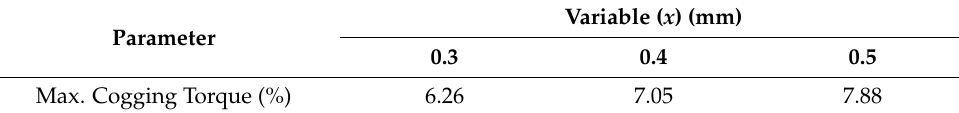
Table 1. Optimization of the asymmetric air gap.